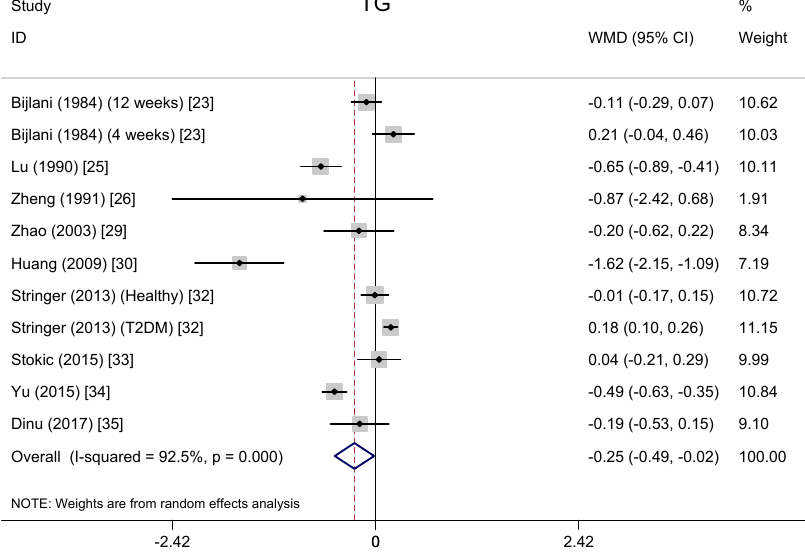
Figure 6. Meta-analysis of the effects of buckwheat products intake on blood triglycerides concentration compared with baseline or control groups for human studies. Sizes of data markers indicate the weight of each study in the analysis. WMD, weighted mean difference (the results were gained from a random-effects model). Negative values favor a reduction in blood triglycerides with buckwheat consumption; the dashed line shows the overall WMD value and the size of the rhombus the cumulative effect size and CI.